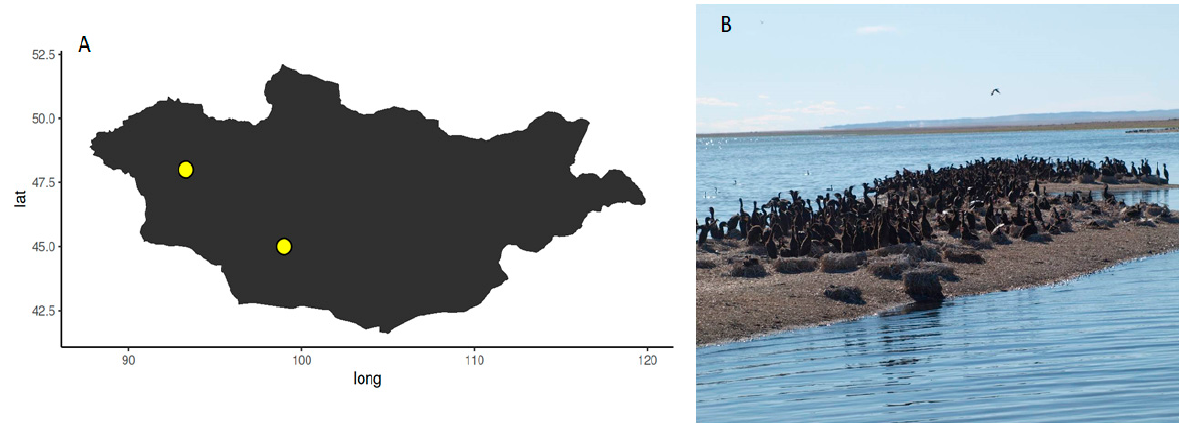
Figure 1. ( A ) Map of Mongolia depicting the sample locations of E. coli isolates; ( B ) cormorant colony-1 on an island in the lake Buuntsagaan, Bayankhongor province (N48° E93.19 ′ 19.2 ″ ).